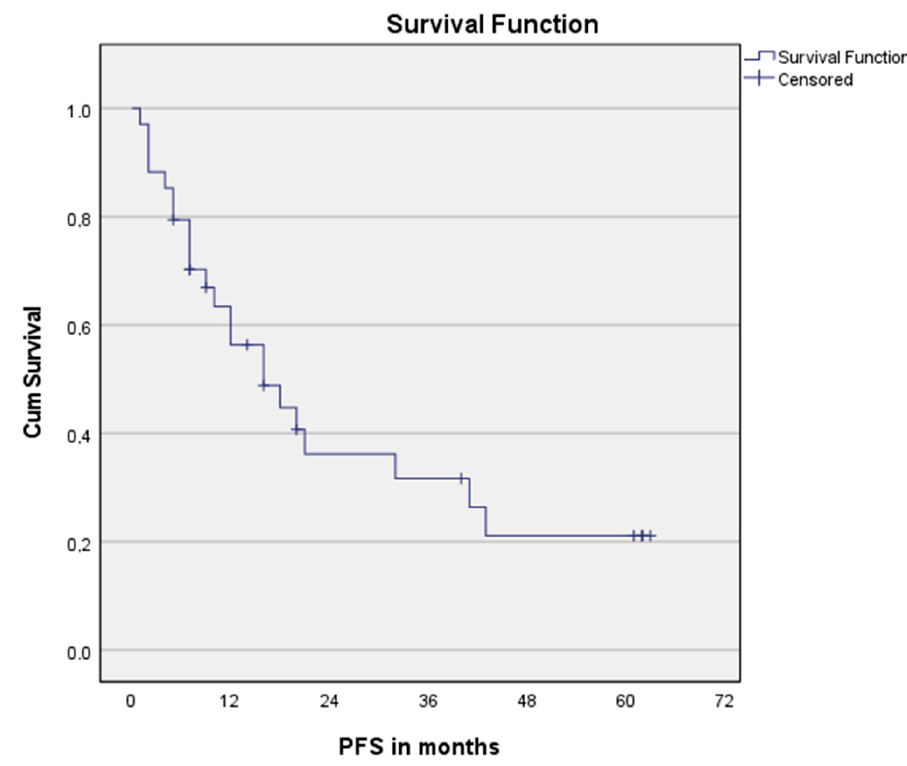
Figure 2. Progression-free survival for the entire cohort. n = 34. In the univariate Cox regression model, treatment regimen (nCRT vs. dCRT) signifi- cantly affected OS, but not PFS, see Figures 3 and 4, respectively. The trend shown is in-